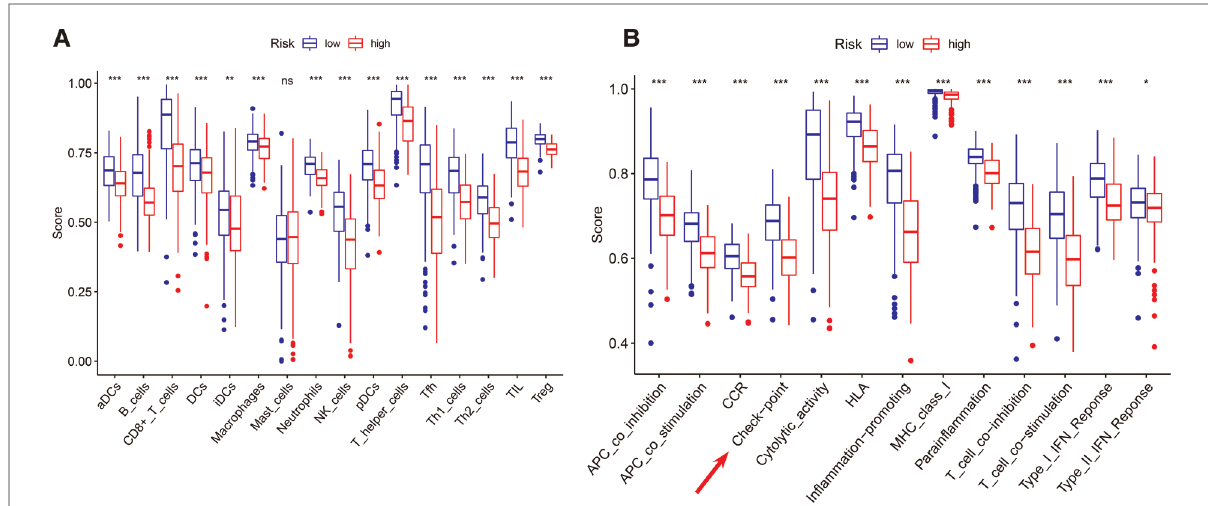
FIGURE 7 ssGSEA analyses ( A ) comparison of ssGSEA scores for 16 immune cells between the high- and low-risk groups. ( B ) A comparison of the 2 groups ’ ssGSEA scores for 13 immune functions indicates that the high-risk group had a signi fi cantly lower the checkpoint score. * P <0.05; ** P <0.01; *** P < 0.001.